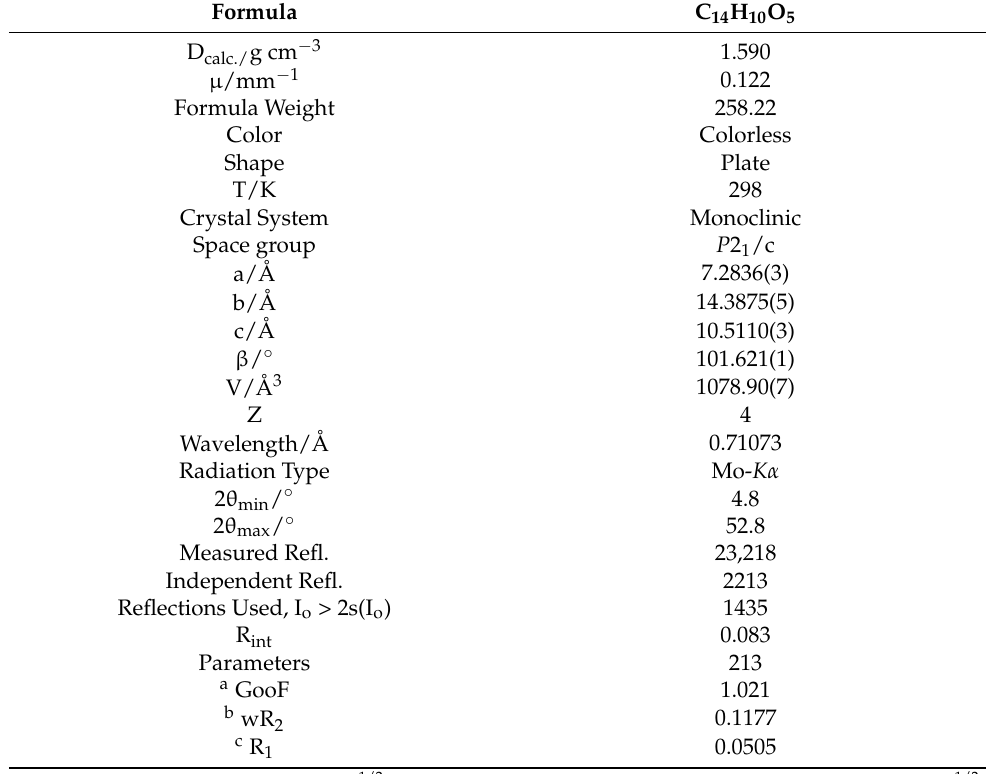
Table 1. Crystal data and structure refinement parameters for alternariol—Form